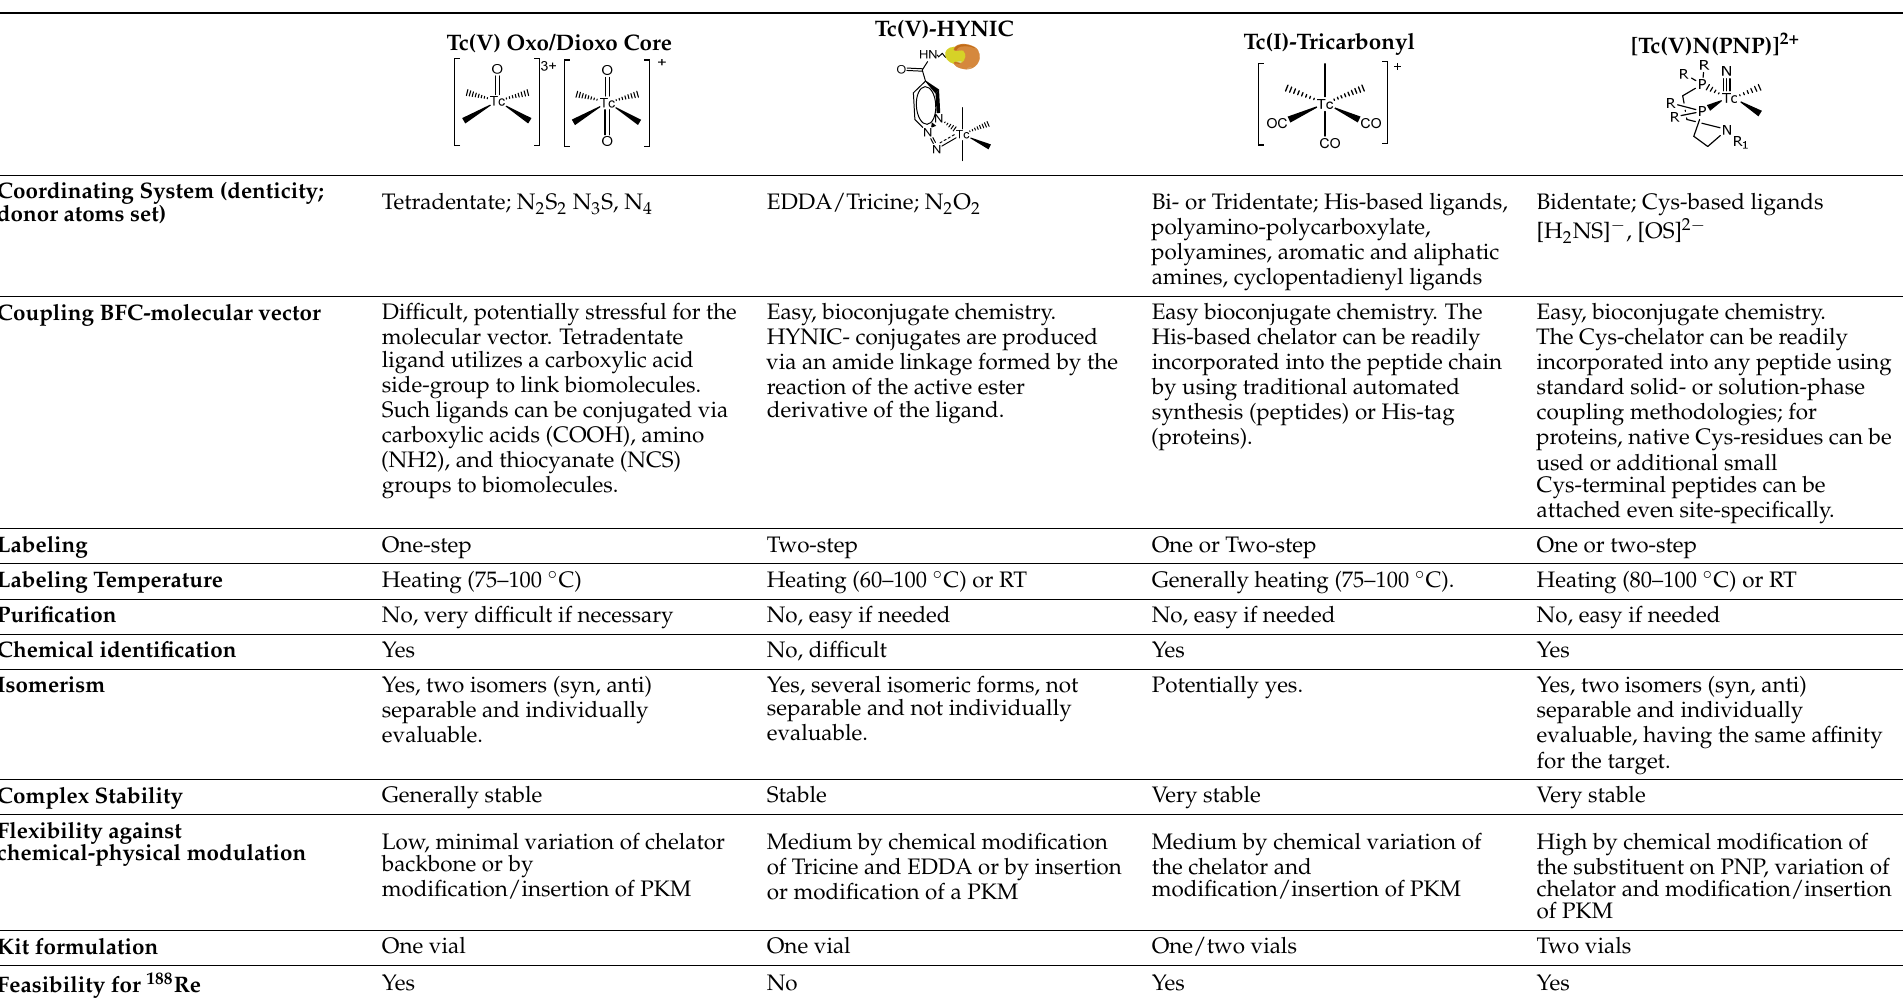
Table 2. Summary of features of Technetium-99m labeling approaches.